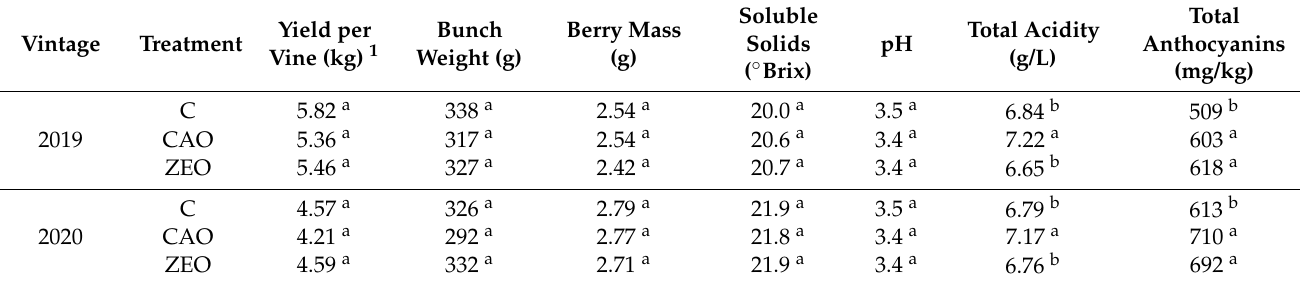
Table 6. Yield parameter and fruit components recorded in Sangiovese vines undergoing Kaolin (CAO) and Chabasite-rich zeolitite (ZEO) treatments and the control (C) vines in 2019 and 2020. Different letters in a column for a given year indicate significant differences after the Tukey statistical analysis test ( p ≤ 0.05).